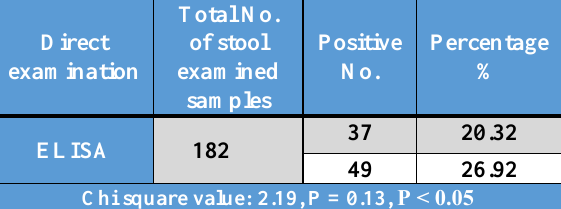
Table, 1: Prevalence of G. lamblia in asymptomatic patients according to type of detection test.